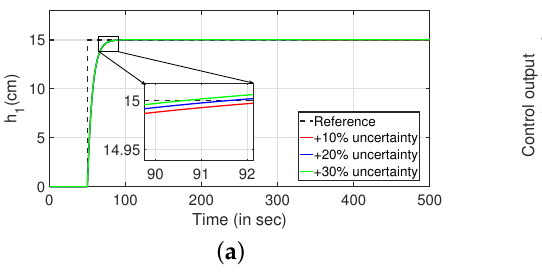
Figure 17. Reference tracking for PID controller with input uncertainties. ( a ) Level Variation in tank 1. ( b ) Level Variation in tank 2.